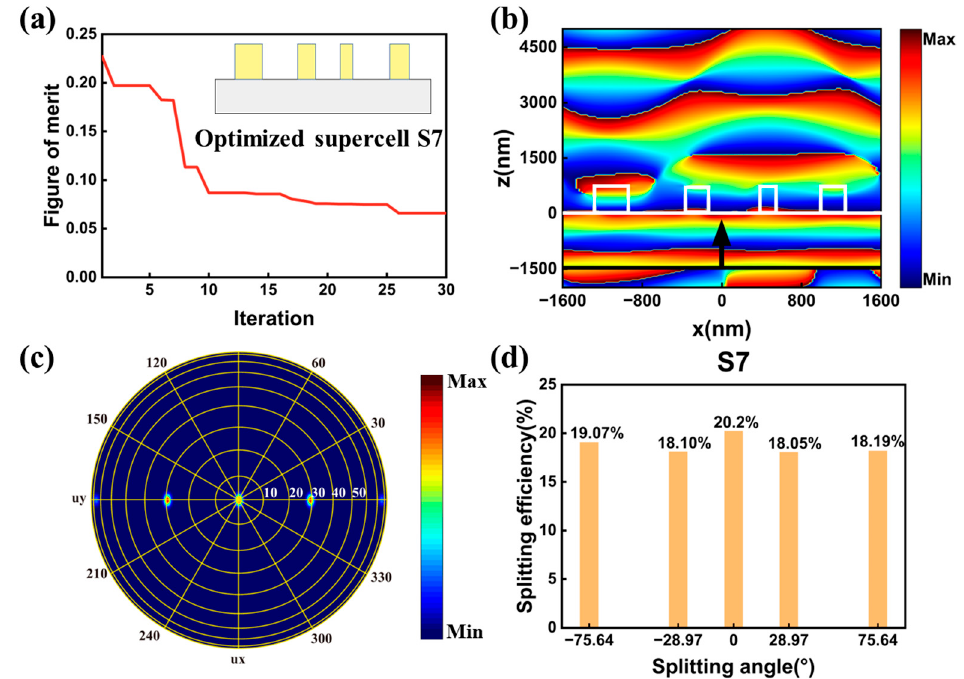
Figure 5. ( a ) The optimization trajectory of metasurface for five-port splitting output. The insert in ( a ) is the schematic of the optimized supercell. ( b ) The phase distribution profile of electric field Ex in the x-z plane for the optimized supercell S7. The white lines depict the boundaries of the nanocylinders and substrate, and the black line and arrow represent the location and direction of the incident light. ( c ) The far field distribution of the five splitting channels. ( d ) The calculated efficiencies at different splitting channels in supercell S7.